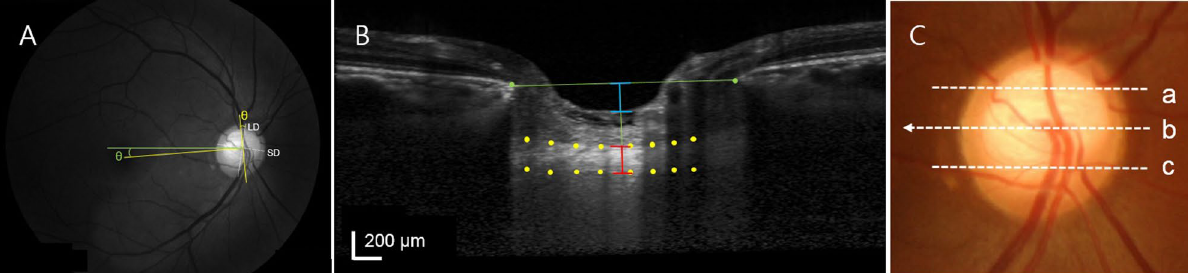
Figure 4. The optic disc morphological features (disc tilt, disc torsion, and disc-foveal angle) and optic nerve head (ONH) parameters (prelaminar thickness, lamina cribrosa [LC] depth, and LC thickness) were measured using disc and retinal nerve fiber layer photographs and B-scans from spectral-domain optical coherence tomography (SD-OCT). ( A ) , The disc tilt was determined using the disc ovality ratio. Disc ovality ratio was the ratio between the longest disc diameter (LD) and shortest disc diameter (SD) ( white dotted lines ). Disc torsion refers to the deviation of the long disc (LD) axis from the vertical meridian ( i.e ., the vertical line perpendicular to a reference line connecting the fovea and the disc center; yellow lines). The angle ( yellow θ ) between the vertical meridian and the long axis of the disc is the degree of torsion. The disc-foveal angle ( green θ ) is the angle between the optic disc and fovea as measured by the angle between the reference line ( yellow line ) and a horizontal line through the disc center ( green line ). (B ), To measure the ONH parameters, the end of Bruch’s membrane was marked (green glyph) and connected by the reference line (green line). From the center of the reference line, a perpendicular line was drawn and measurements were made along this line. Prelaminar thickness was the distance between the center of the reference line to the anterior surface of the ONH (marked as blue section). LC thickness was the distance between the anterior and posterior borders of the LC which appears as a hyperreflective region at the bottom of the ONH (marked as red section). The LC depth was determined by measuring the distance from the center of the reference line to the anterior surface of the LC. ONH parameters were measured at three locations from each B-scans that scanned three regions ( a , b , c ) of the ONH and average of three values were